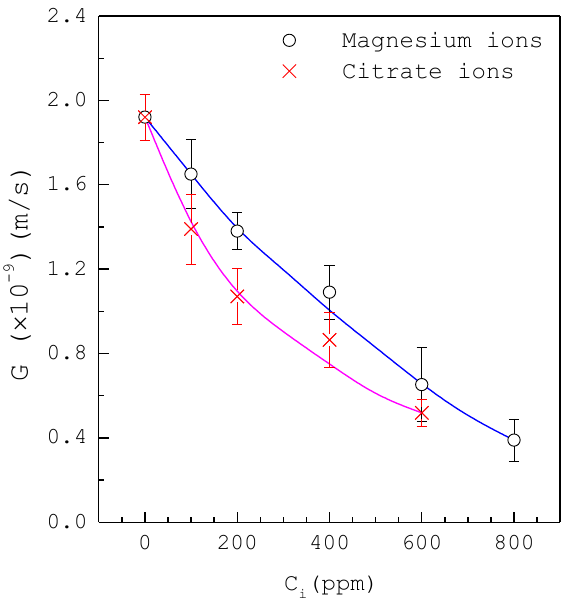
Figure 5. The decrease of the growth rate with increasing inhibitor concentration of magnesium ions or citrate ions for 𝑆 = 13.65 at 37 ℃ . Each point represents the mean growth rate for eight crystals and the error bar represents the 95% confidence interval for the growth rate. Lines are visual guides.